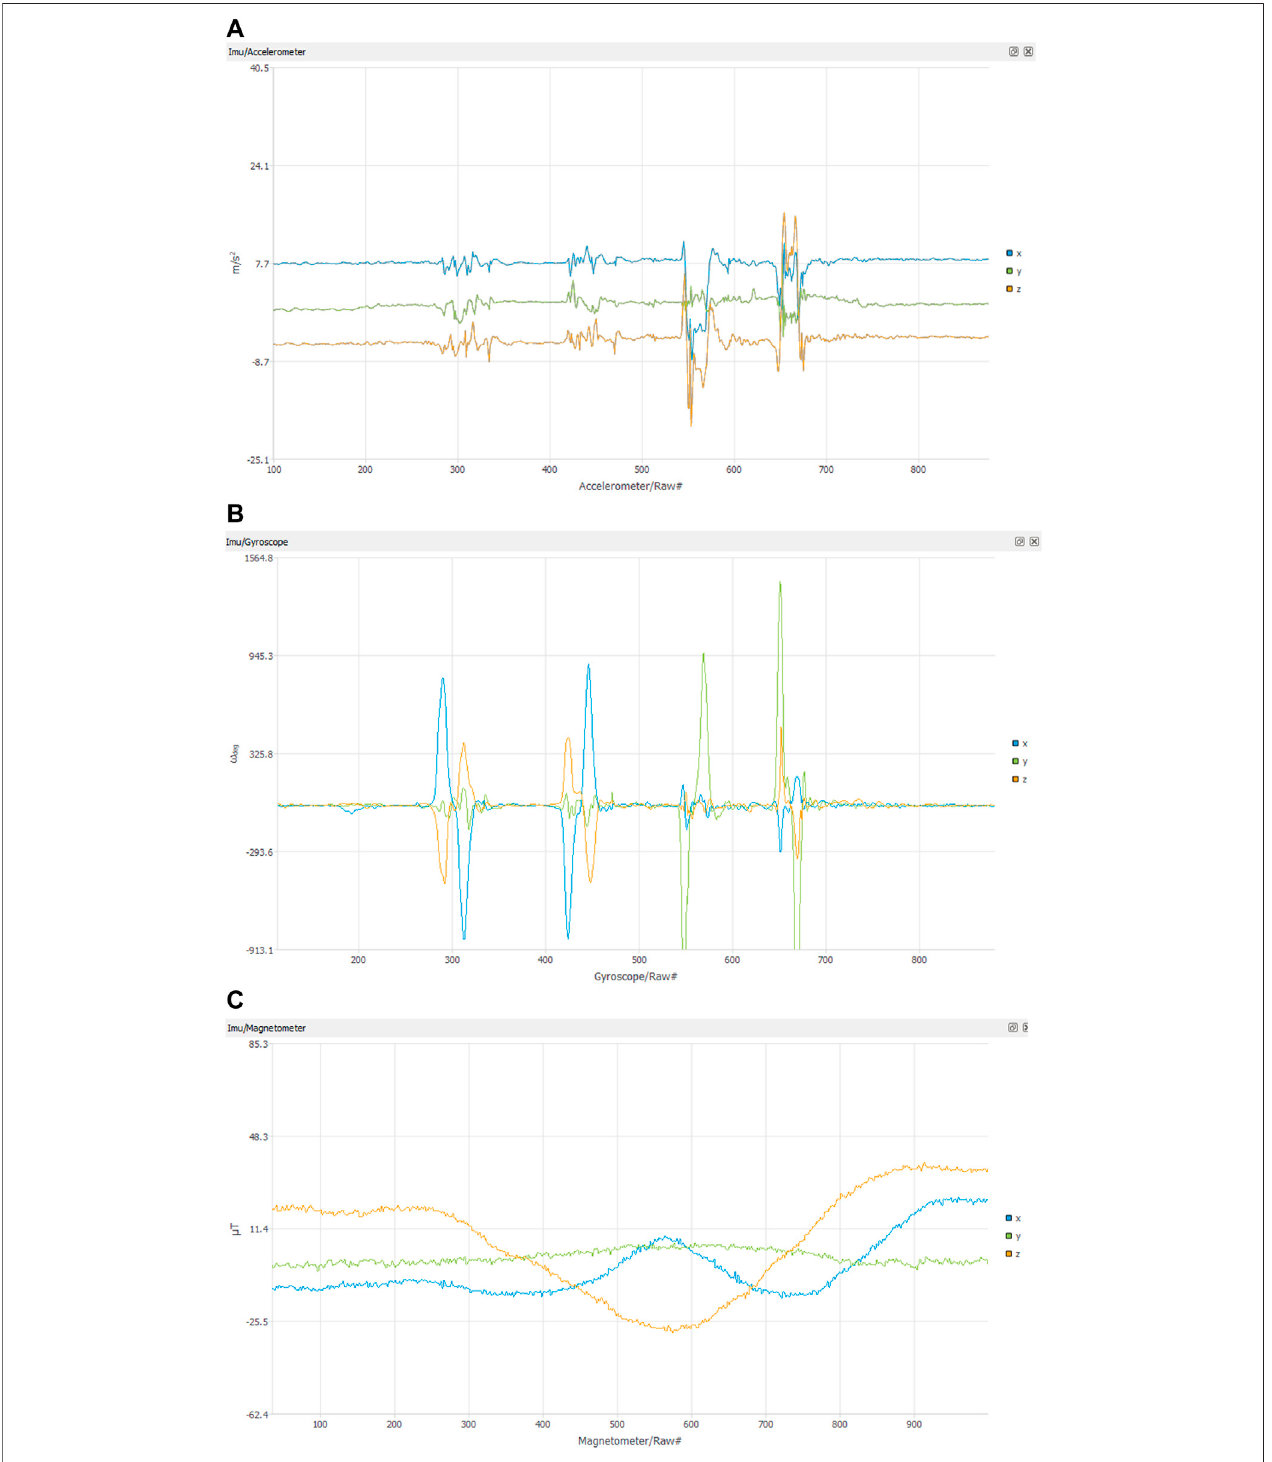
FIGURE 14 | Data from IMU sensor for x , y and z -axis. (A) accelerometer measuring acceleration. (B) gyroscope measuring angular. (C) Data from magnetometer measuringstrengthanddirectionofthemagnetic fi eld.ForAandB,theparticipantwasaskedtoturntheirheadineachofthefourdirections(left,right,upanddown).For C, the participant was asked to slowly look down and up.